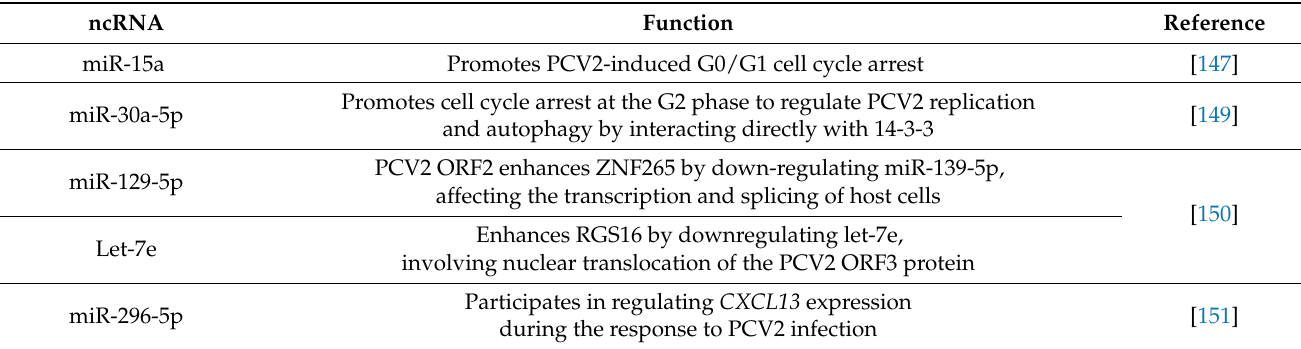
Table 1. Possible roles of non-coding RNAs in PCV